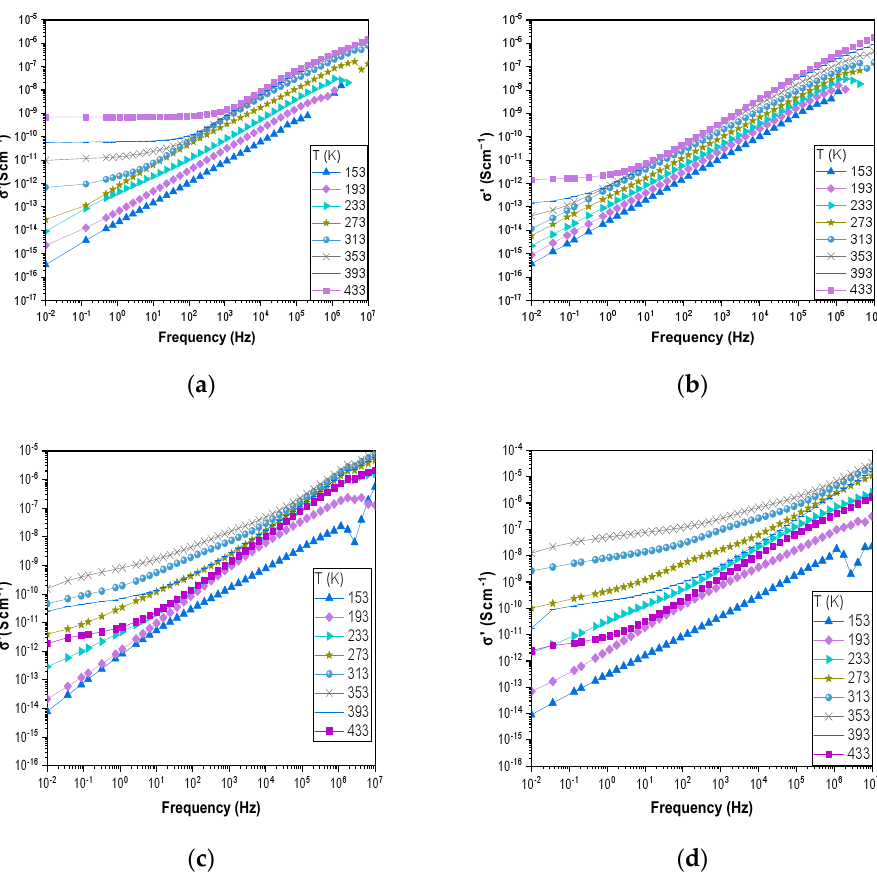
Figure 10. Variations in real part of AC conductivity with frequency at different temperatures for ( a ) PPDA and PPDA/MMT composites: ( b ) PPDA − 5, ( c ) PPDA − 35 and ( d ) PPDA − 50.